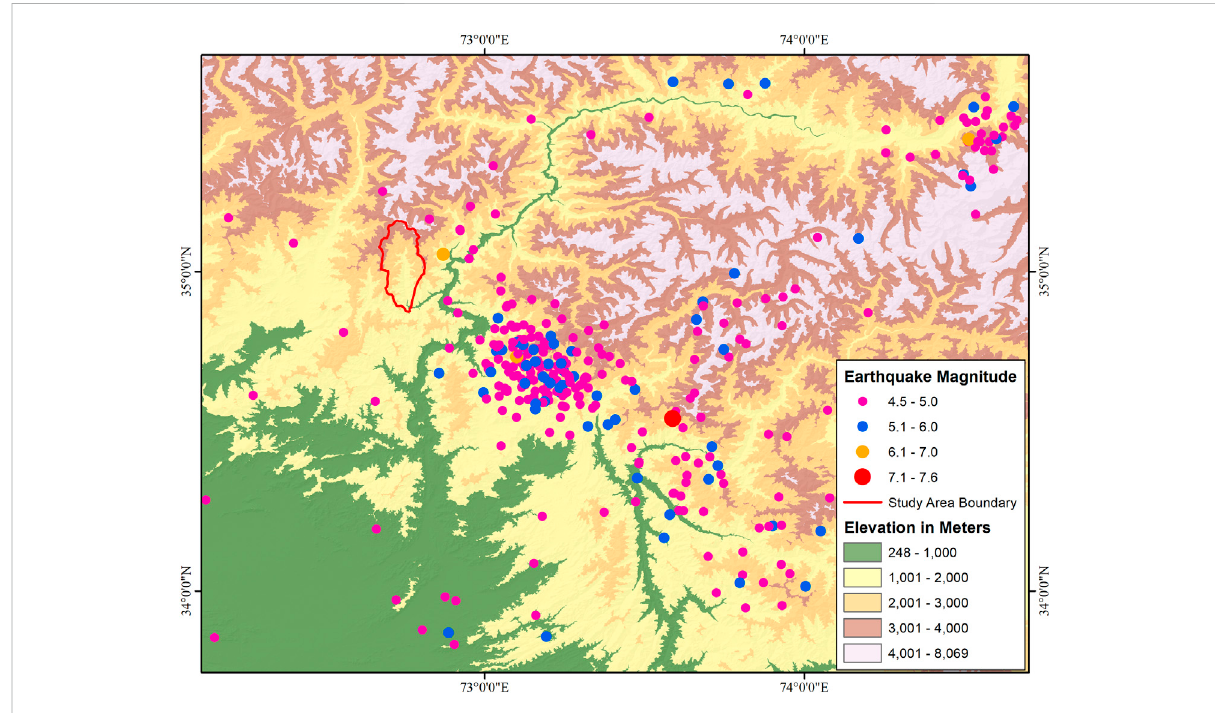
FIGURE 2 Shahpur valley and surroundings: spatial distribution of earthquake